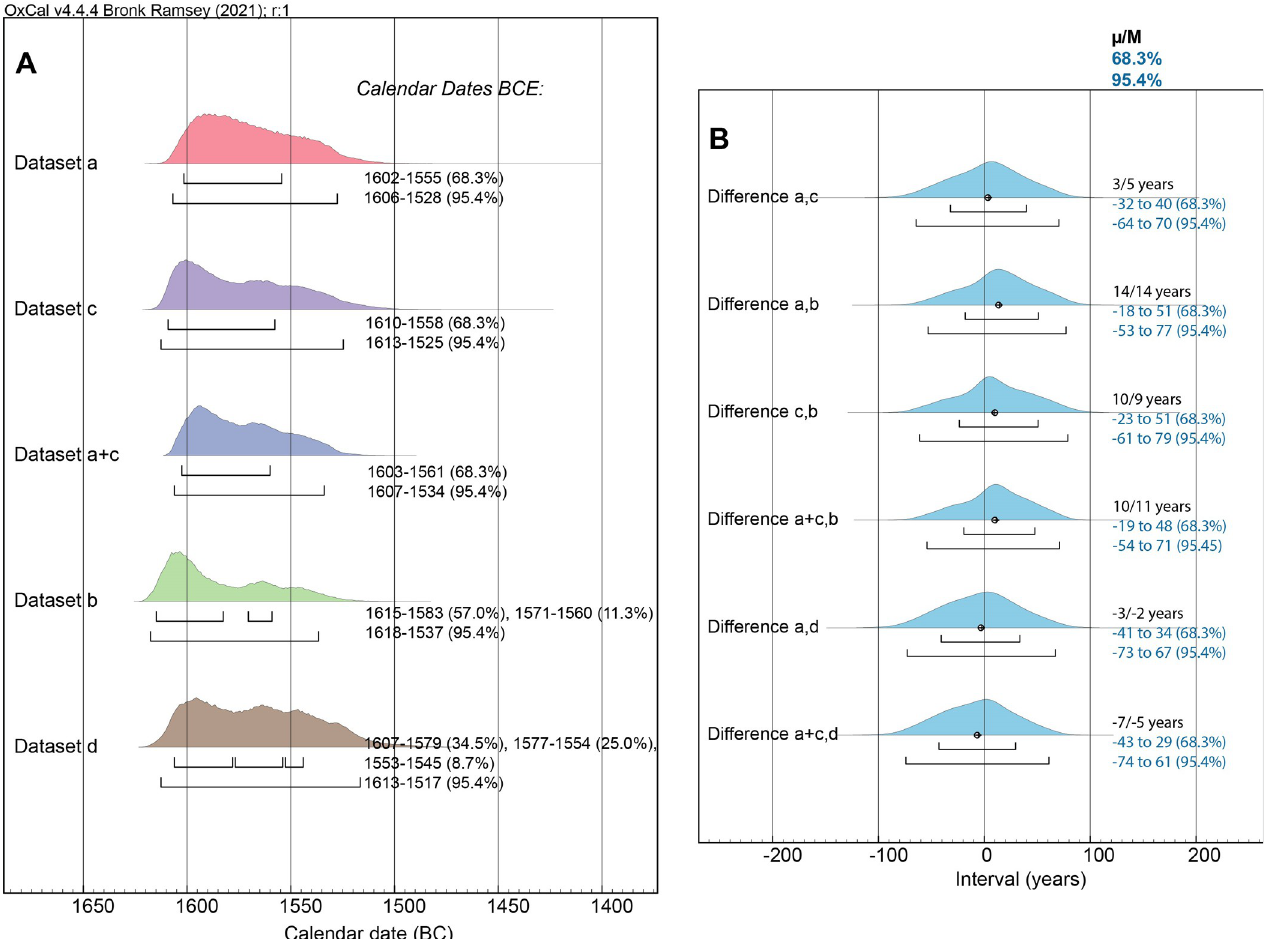
Fig 7. Comparison of the calendar dating probabilities for the Boundary after the datasets (a), (b), (c) and (d), and for dataset (a)+(c), and investigation of likely temporal difference between these datasets. (A) The posterior probability distributions from the models for each dataset and for datasets (a)+(c) combined with the 68.3% and 95.4% hpd ranges indicated by the upper and lower lines under each distribution. (B) The time interval (OxCal Difference query) between the posterior probability distributions–from (A)–for dataset (a) versus (c) and (a) versus (b), for dataset (c) versus (b), for datasets (a)+(c) versus (b), for dataset (a) versus (d) and for datasets (a)+(c) versus (d). The mean ( μ ) and median (M) of each difference is stated (in calendar years) as well as the 68.3% and 95.4% probability ranges.